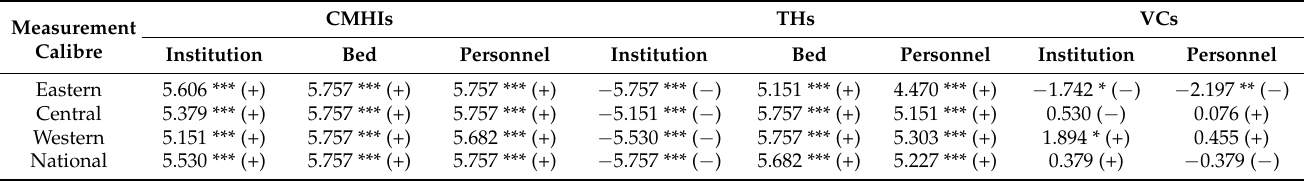
Table 4. Mann–Kendall test results of HRDI (CMHIs: county and county-level city medical and health institutions; THs: township hospitals; VCs: village clinics). CMHIs THs Measurement Calibre